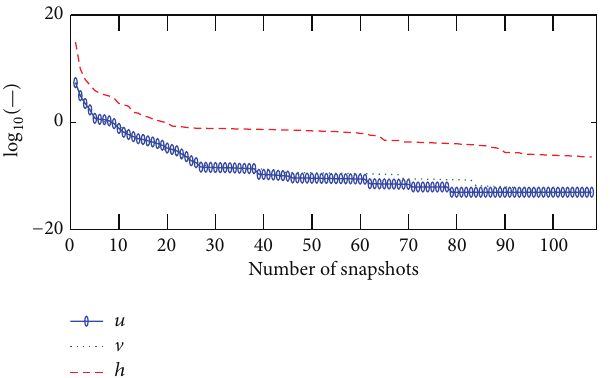
Figure 3: Singular values of snapshots solutions.